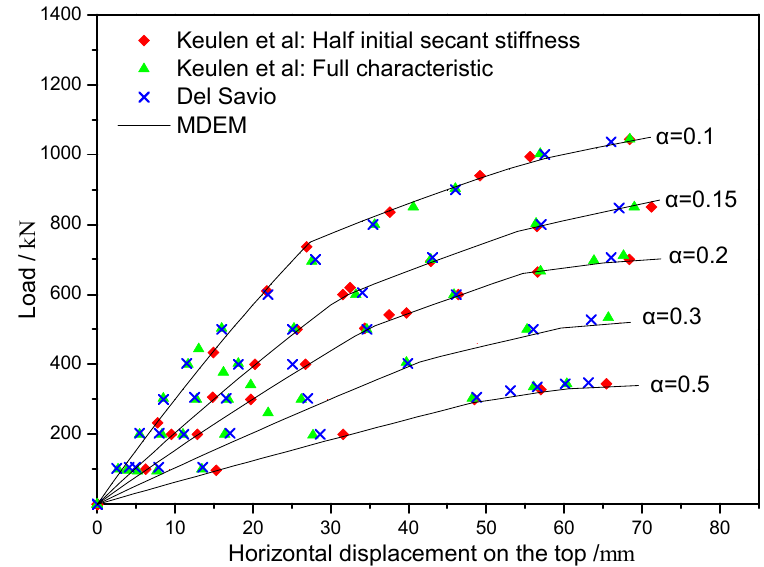
Figure 15. Displacement response on the top of the steel frame.